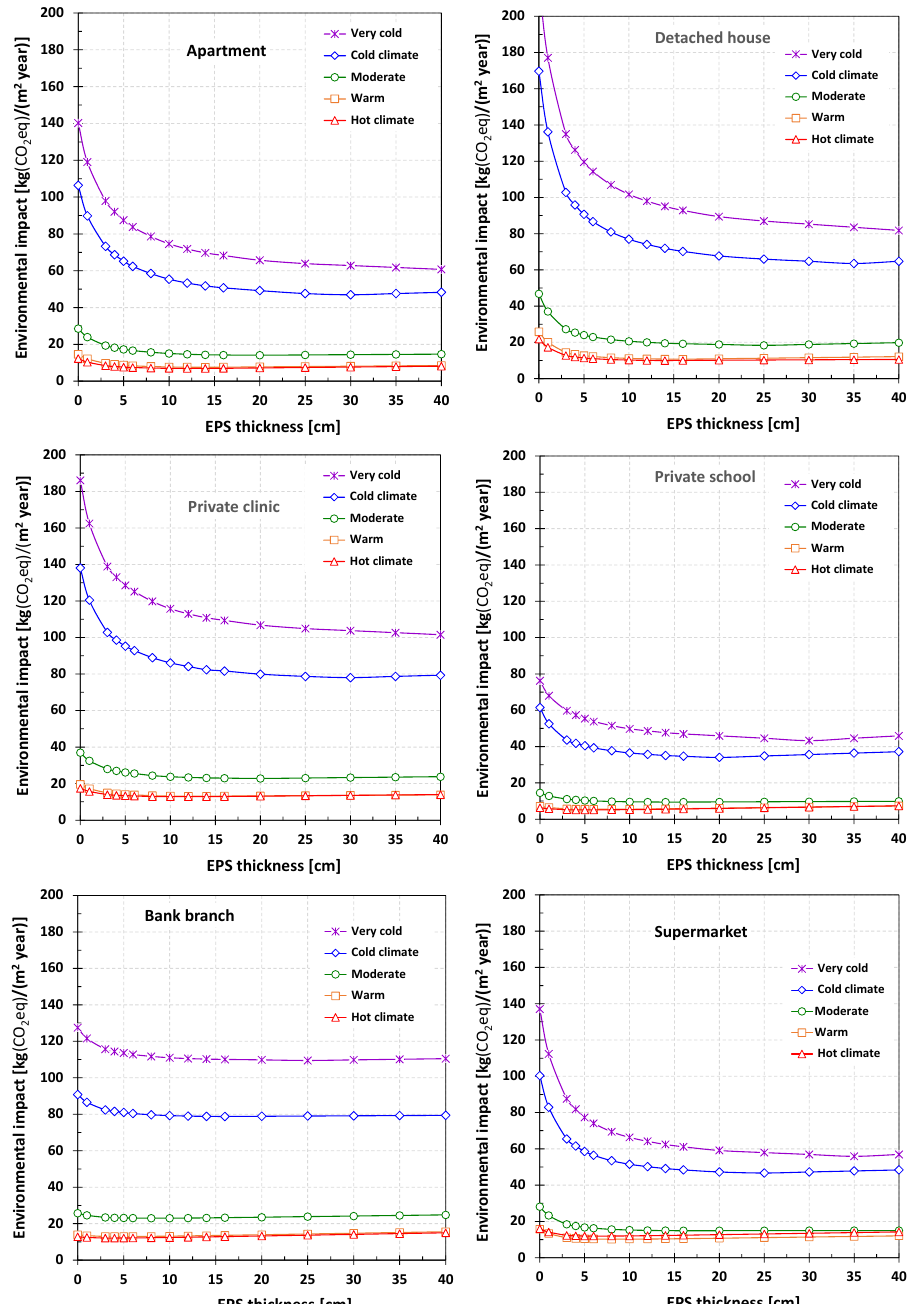
Figure 5. CO 2 equivalent emissions to maintain thermal comfort conditions.